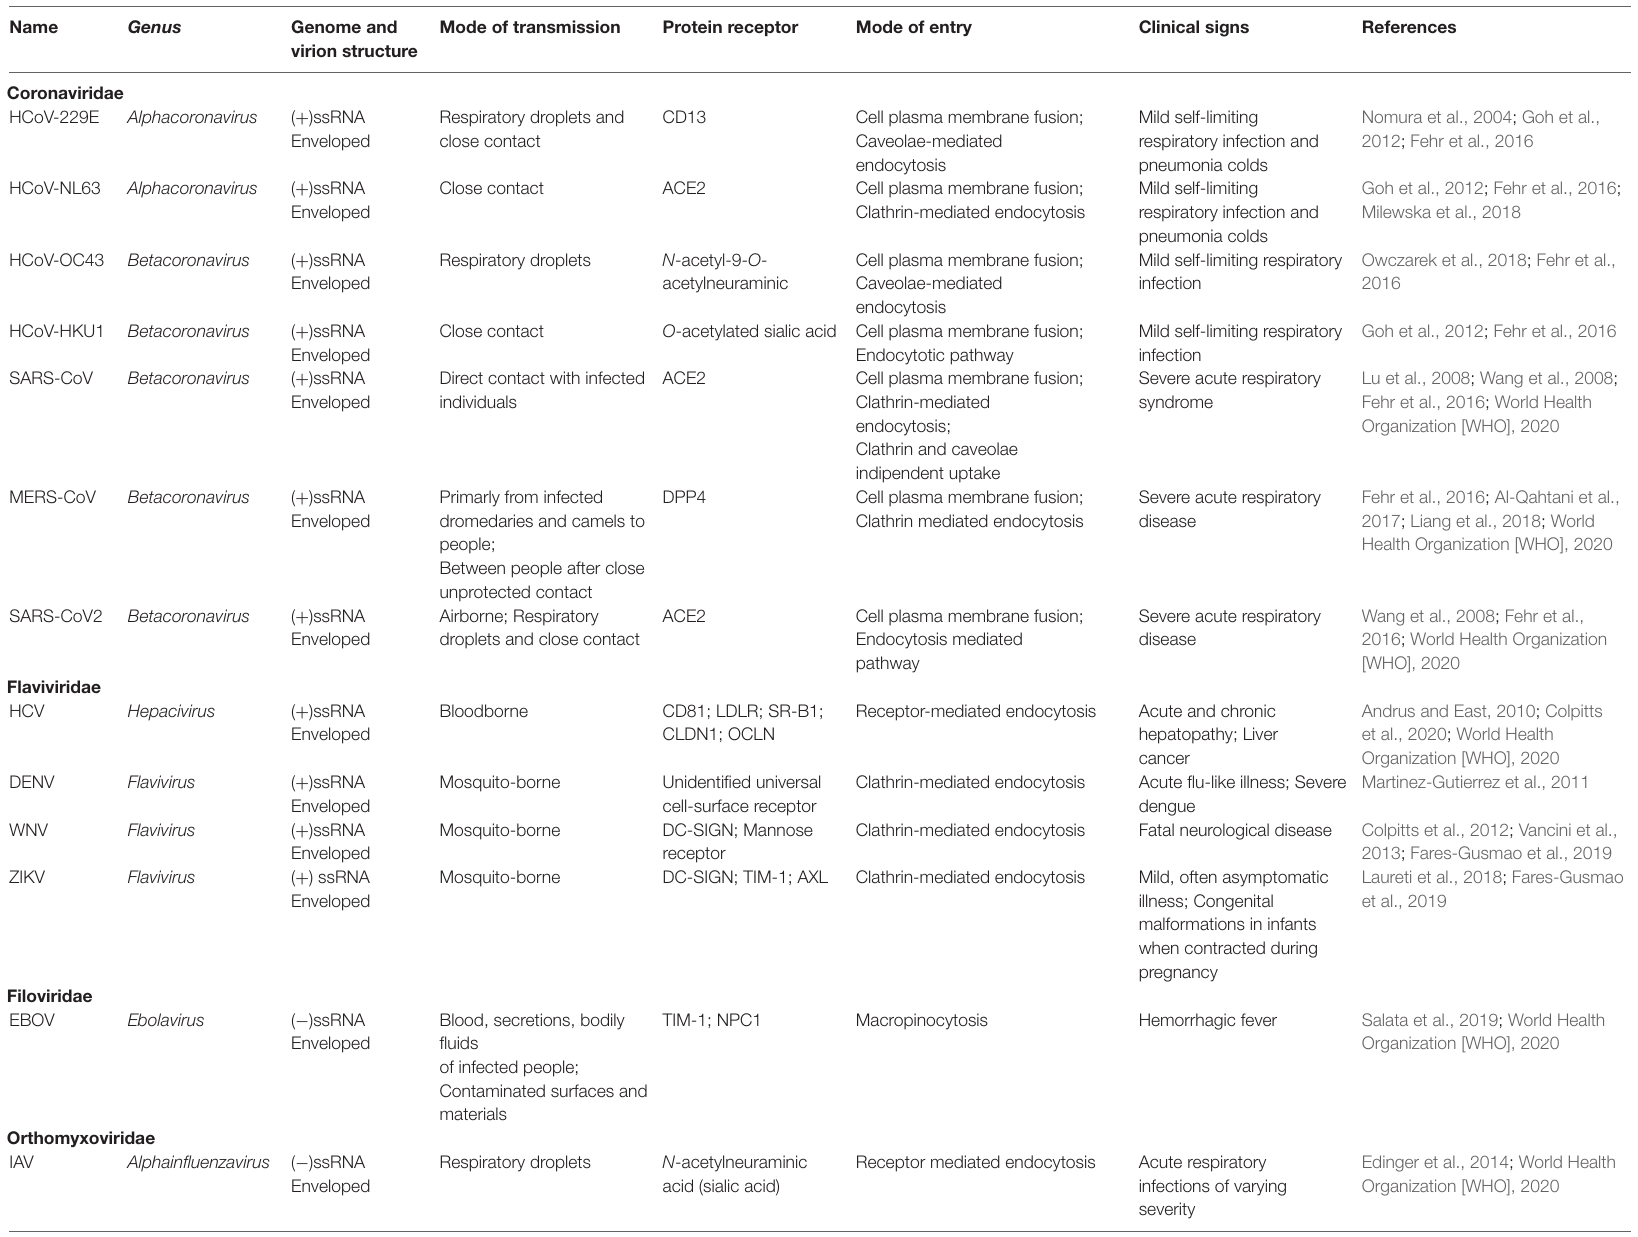
TABLE 1 | Genetic characteristics, transmission, and clinical signs of ssRNA